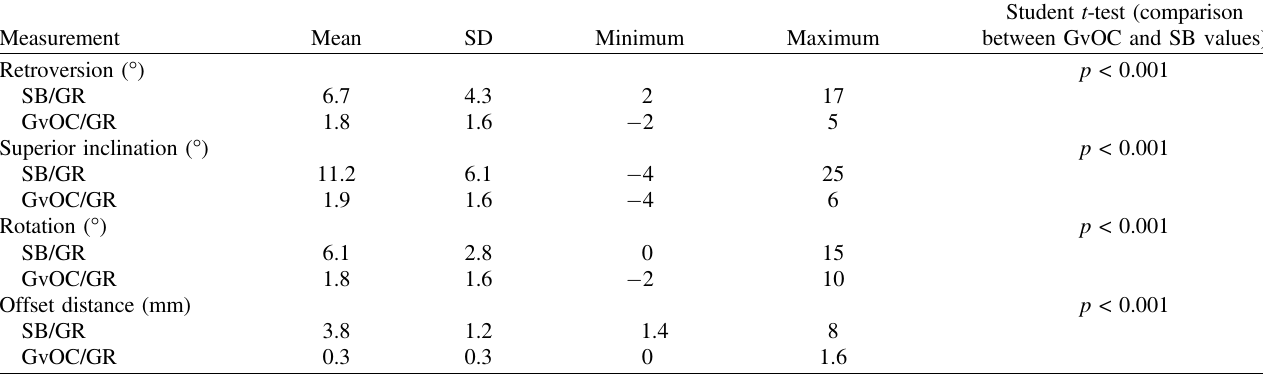
Table 1. Relative positions of SB vs. GR and GvOC vs. GR in the 105 scapulae.